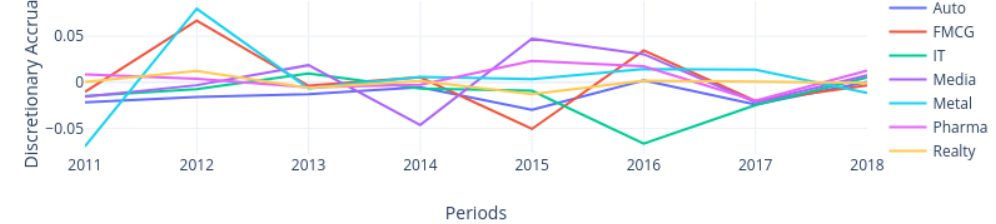
Figure 1. Discretionary Accruals over the years for the seven sectors.